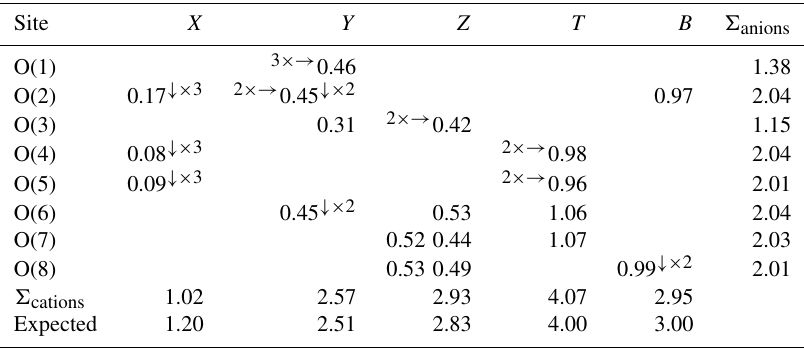
Table 8. Weighted bond valence (in valence units) in dutrowite.